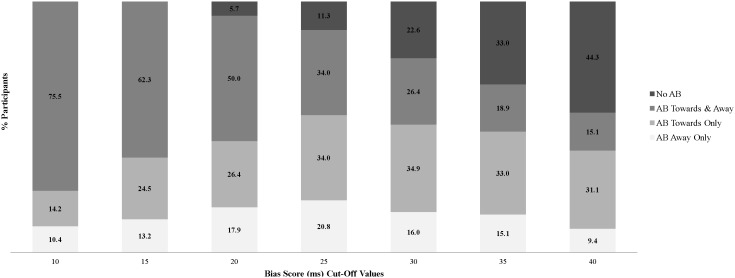
Rates of the Multiple Expressions of Attentional Bias to Threat as a function of Bias Score Cut-Off Values among Anxious Participants (N = 106).